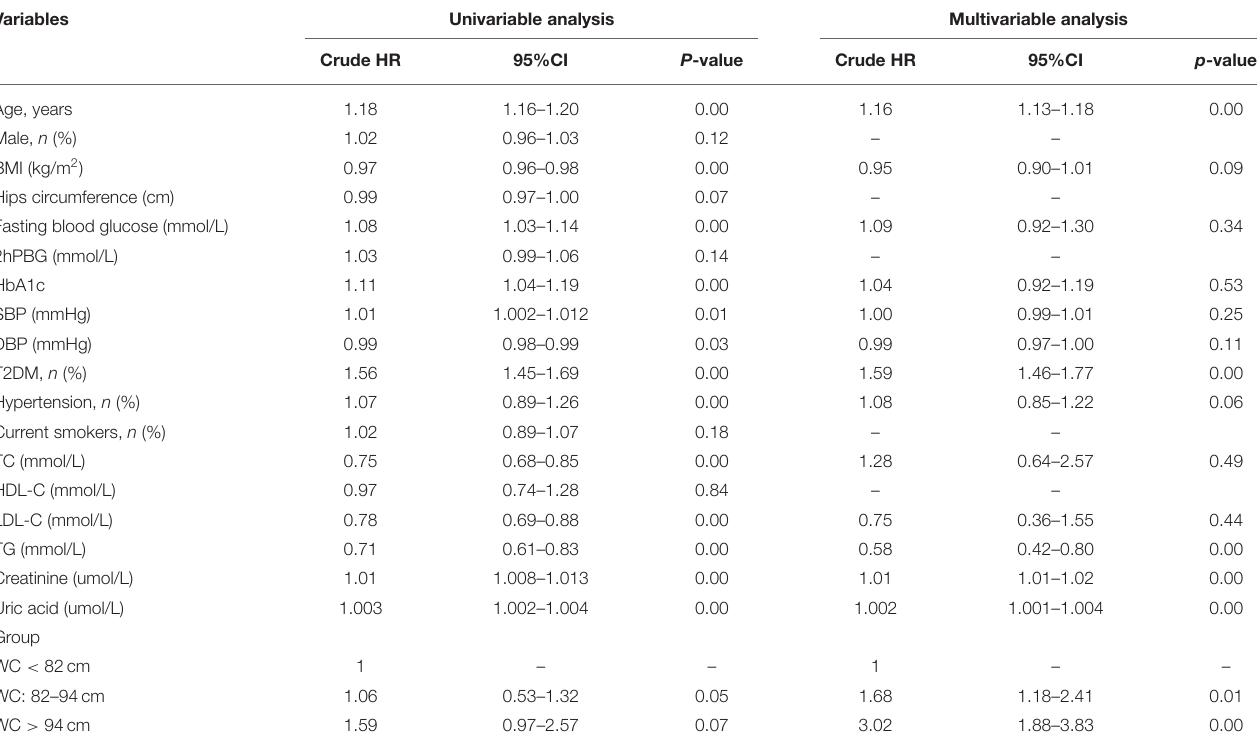
TABLE 2 | Univariate and multivariate Cox regression analyses of cardiovascular death predictors.